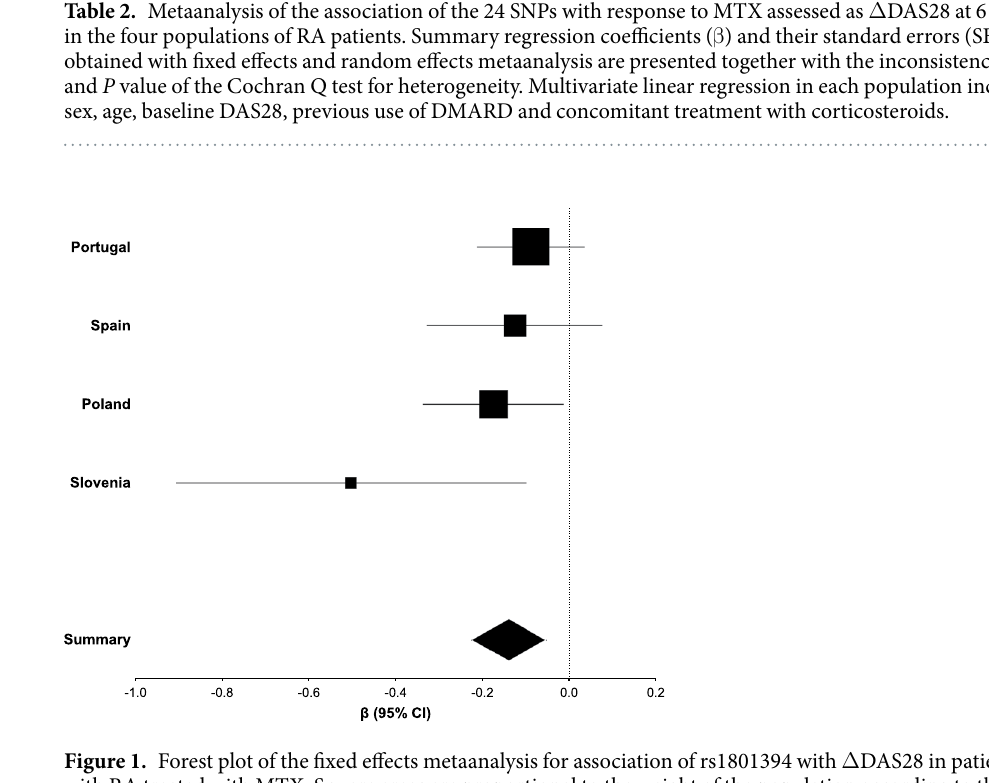
Figure 1. Forest plot of the fixed effects metaanalysis for association of rs1801394 with Δ DAS28 in patients with RA treated with MTX. Square areas are proportional to the weight of the population according to the inverse variance method. Width of the diamond represents the 95% CI of the summary regression